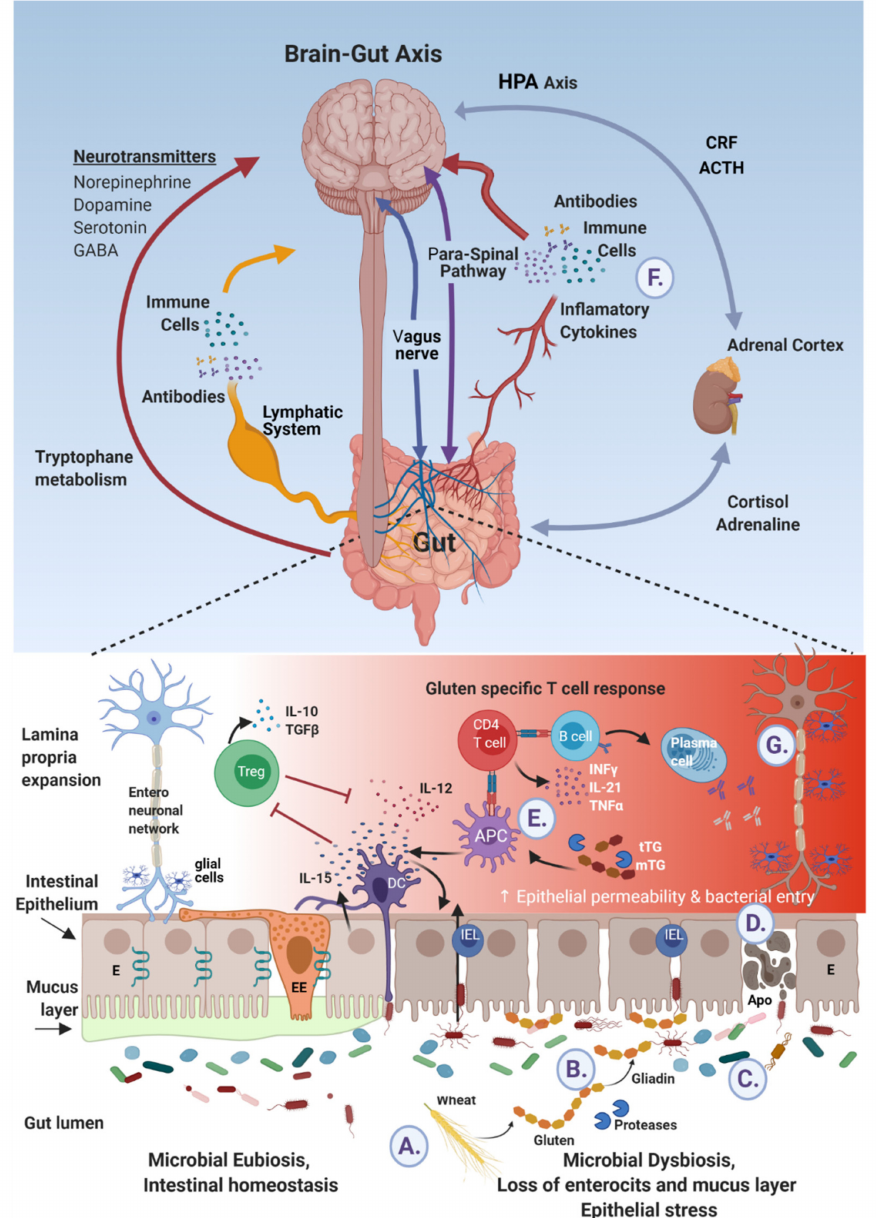
Figure 2. Ingested gluten and gliadin’s peptides cross talks with brain epitopes in neurodegenerative diseases. ( A ) Wheat reach gluten is ingested and digested to gliadin peptides. ( B ) By deamidation and cross-linking, luminal and mucosal tissue and microbial transglutaminases post translate